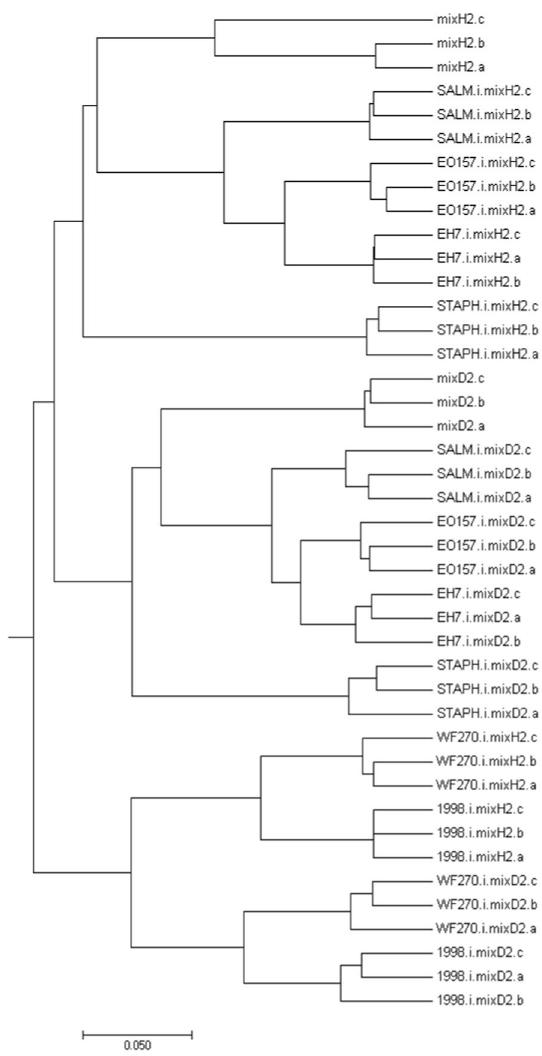
Figure 5. Hierarchical clustering of samples before antibiotic therapy (mixH2) and after antibiotic therapy (mixD2) cultured in WCAB (Wilkins Chalgren Anaerobe Broth) conditioned media of four different